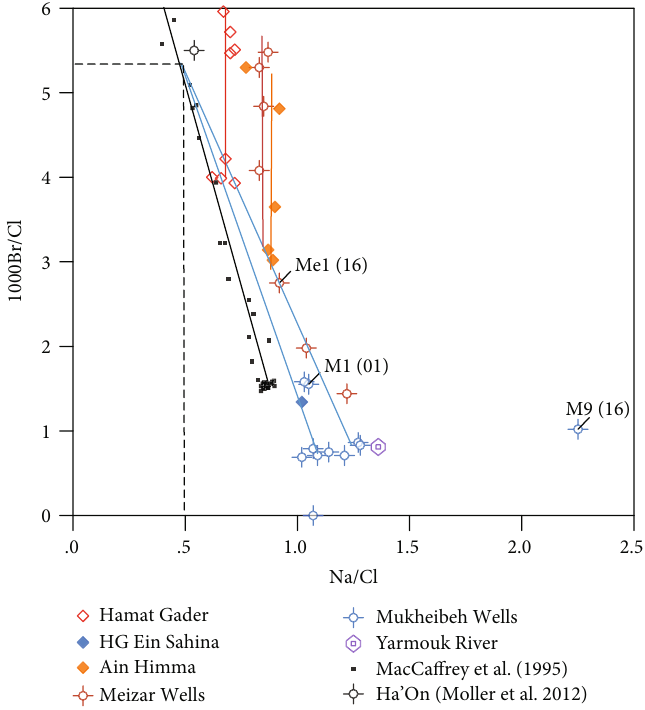
Figure 9: Crossplots of 1000Br/Cl and Na/Cl of the groundwater from the Lower Yarmouk Gorge.